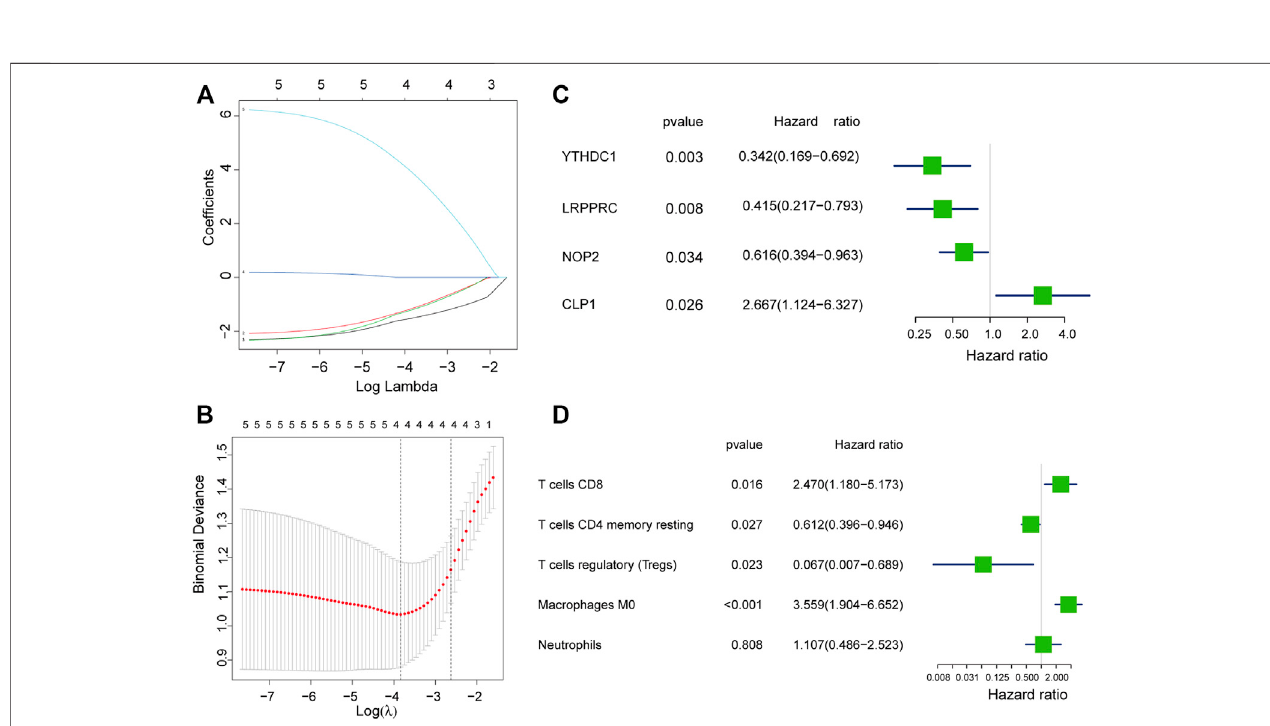
FIGURE 6 | Model construction of hub gene and immune cell. (A,B) : Determine the best penalty value in the LASSO regression algorithm, and screen the RNA modi fi ers and immune cells most related to rheumatoid arthritis. (C,D) : Uses forest plots to display the screened RNA modi fi ers and immune cells.